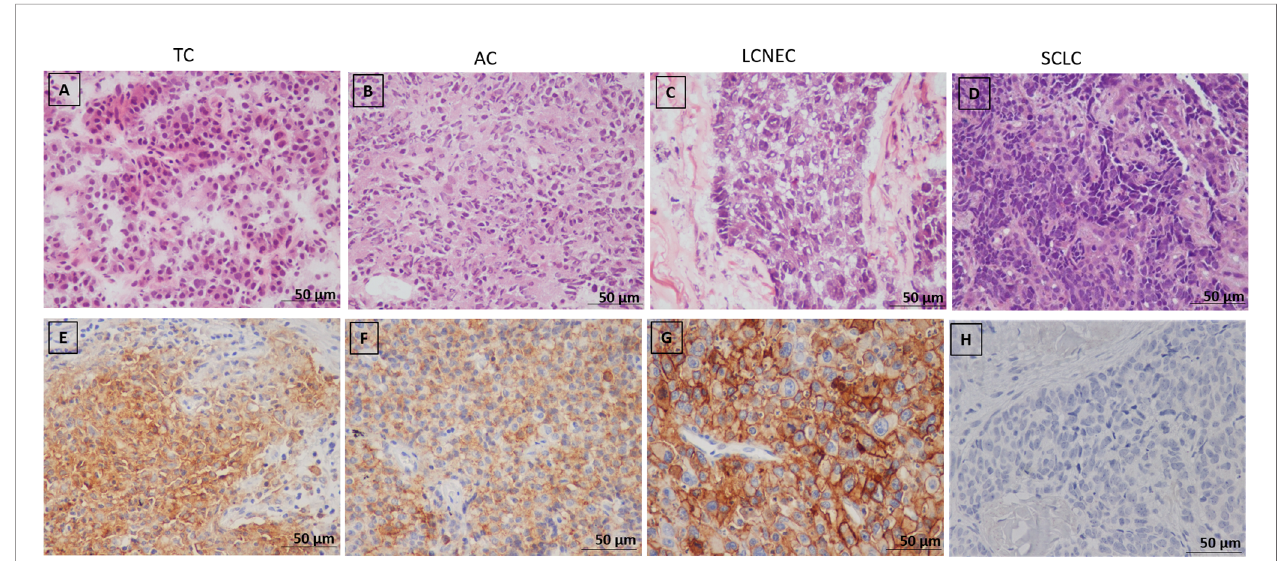
FIGURE 5 | (A – D) Representative microphotographs of pulmonary neuroendocrine neoplasms subtypes (H&E), (A) Typical carcinoid (TC), (B) Atypical carcinoid, (C) Large cell neuroendocrine carcinoma (LCNEC), (D) Small cell lung carcinoma (SCLC); (E – H) Immunohistochemical staining of PD-L1 in PNENs, (E, F) Moderate PD- L1 immunostaining in typical (TC) and atypical carcinoid (AC), respectively; (G) Strong PD-L1 immunostaining in large cell neuroendocrine carcinoma (LCNEC), (H) Negative PD-L1 immunostaining in small cell lung carcinoma (SCLC).